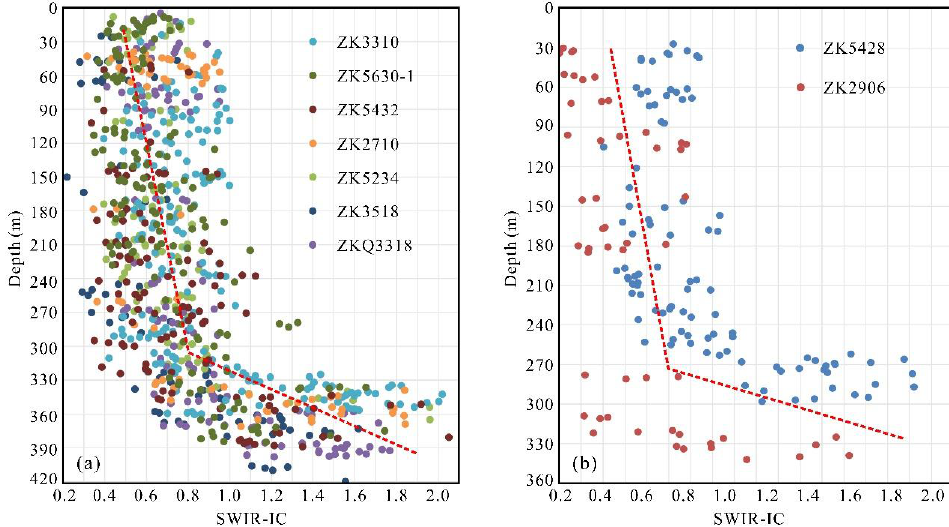
Figure 11. ( a ) SWIR-IC (1000–2500 nm) versus depth for drill holes ZK3310, ZK5630-1, ZK5432, ZK2710, ZK5234, ZK3518, and ZKQ3318. ( b ) SWIR-IC (1000–2500 nm) versus depth for drill holes ZK5428 and ZK2906.